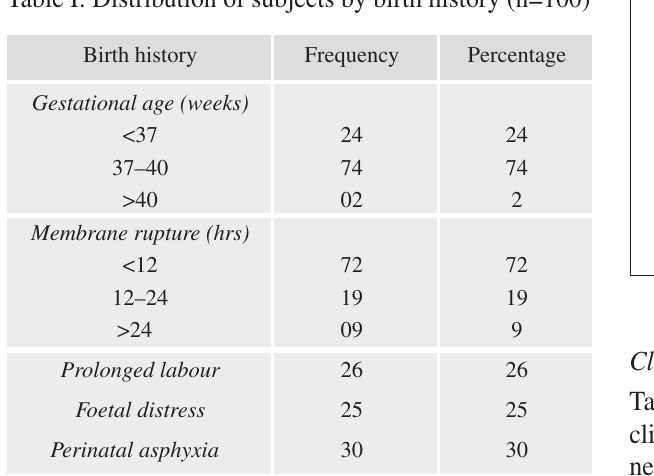
Table I: Distribution of subjects by birth history (n=100)